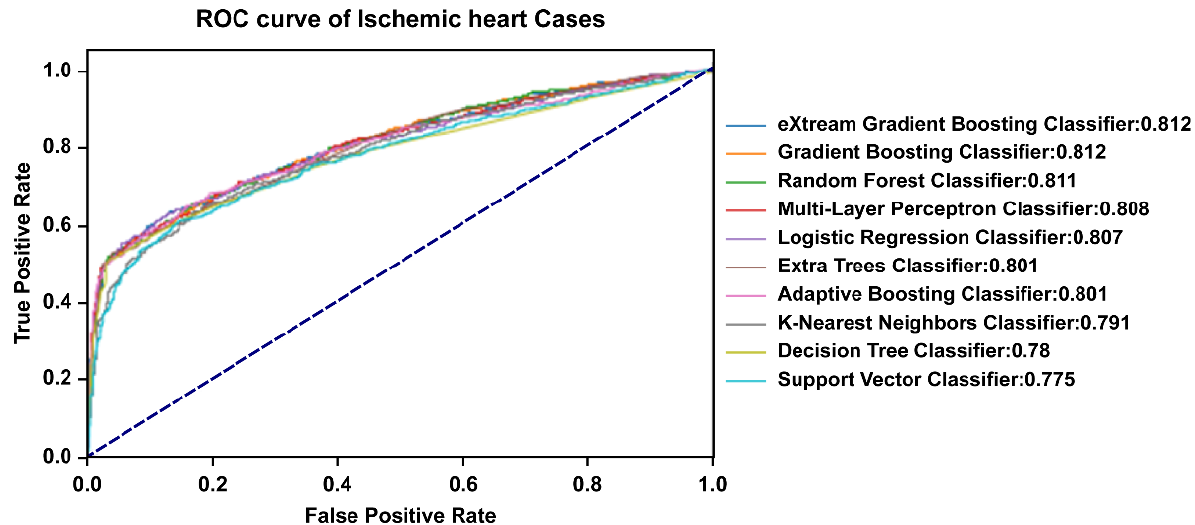
Figure 2. Receiver operating characteristics curve of the prediction performance for each algorithm. The XG boosting, gradient boosting, and random forest algorithms showed the best average prediction accuracy. Table 2. Results of the prediction performance for each algorithm. Trials Mean SD Min 25% 50%